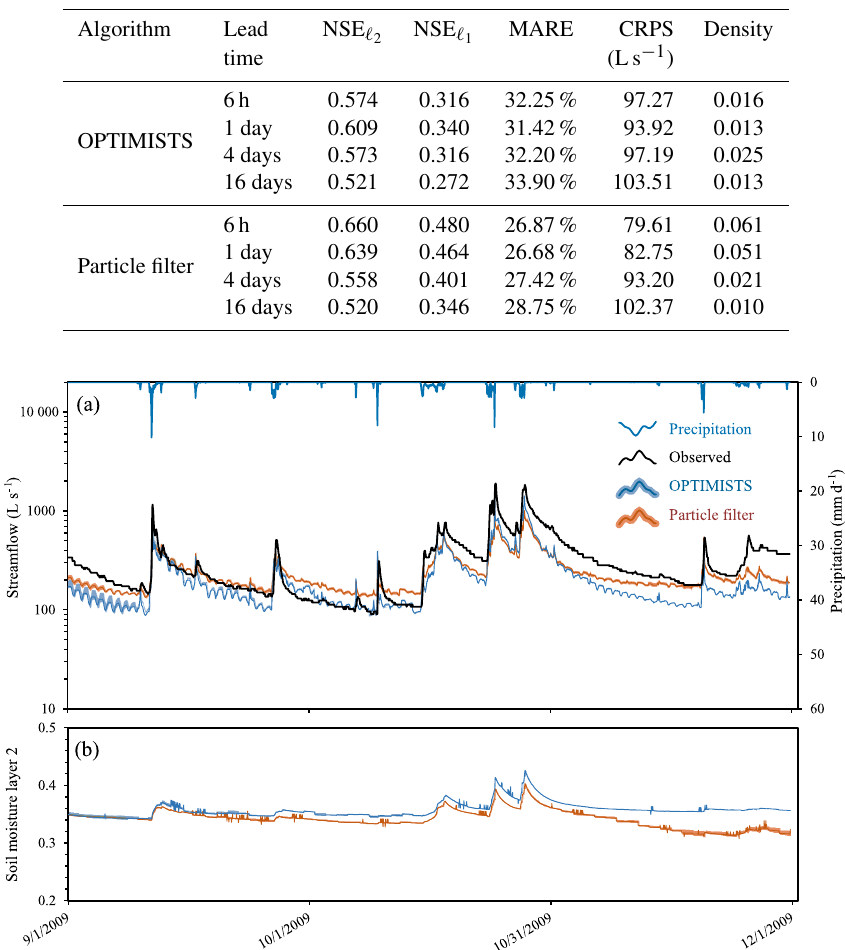
Figure 7. Comparison of 4-day lead time probabilistic streamflow (a) and area-averaged soil moisture (b) forecasts between OPTIMISTS ( (cid:49)t = 7 days, two objectives, n = 50, no optimization, and D-class kernels) and a traditional PF ( n = 50) for the Indiantown Run. The dark blue and orange lines indicate the mean of OPTIMISTS’ and the PF’s ensembles, respectively, while the light blue and light orange bands illustrate the spread of the forecast by highlighting the areas where the probability density of the estimate is at least 50% of the density at the mode (the maximum) at that time step. The green bands indicate areas where the light blue and light orange bands intersect. Layer 2 of the soil corresponds to 100 to 250mm